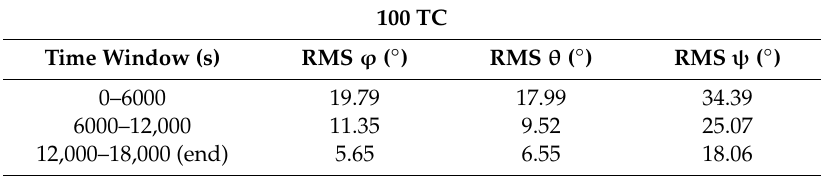
Table 7. Mean Root Mean Square of the attitude estimation errors for the 100 Test Cases.